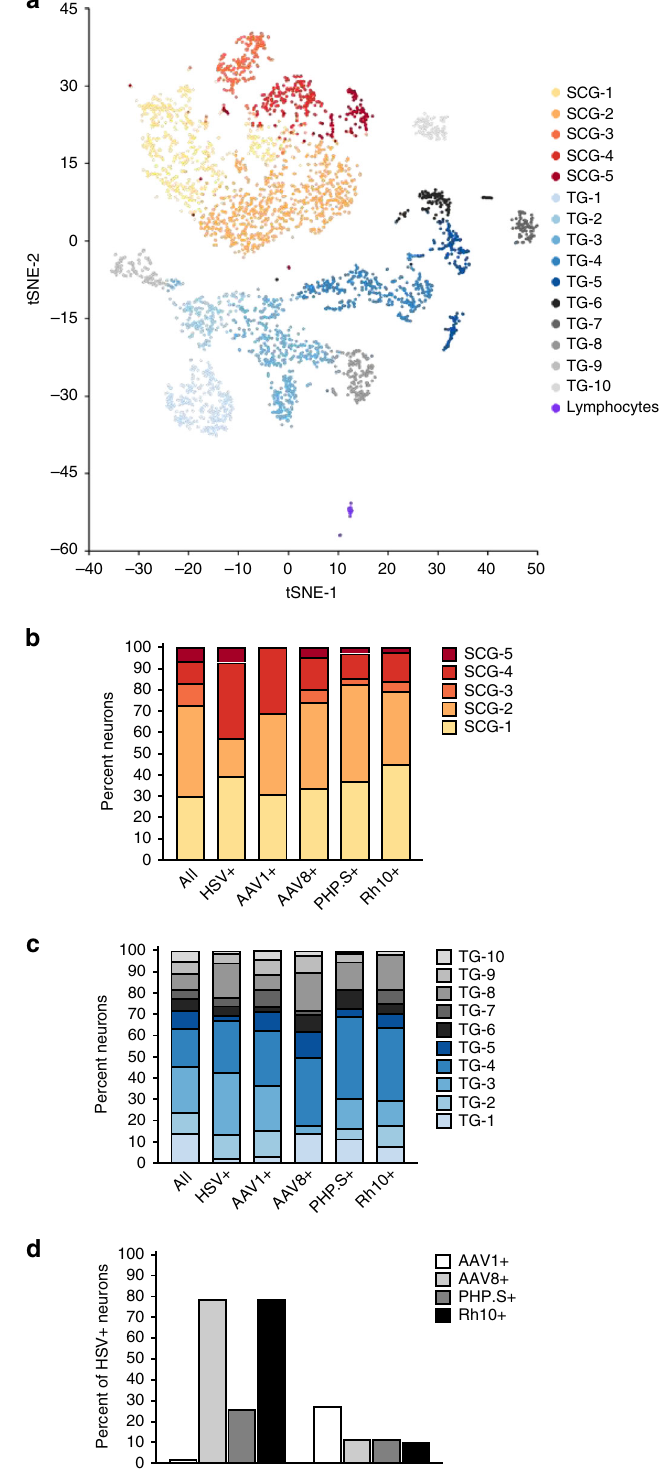
Fig. 7 Single-cell RNA-seq analysis of puri fi ed neurons. a tSNE plot of neurons dividing them into transcriptionally de fi ned clusters. Clusters of the neurons puri fi ed from the SCG ( n = 2041 with 94,797 mean reads and 5635 median genes per cell) colored with orange/red hues (SCG-1 – 5), and neurons puri fi ed from the TG ( n = 2319 with 99,817 mean reads and 5908 median genes per cell) are colored with blue/gray hues (TG-1 – 10). Lymphocytes are purple. b , c Fractional distribution of each neuronal cluster within all neurons, or neurons expressing HSV RNA or the transgenes carried by the indicated AAV serotype, across the SCG and TG. d Calculated percentage of HSV + cells in the SCG and TG that also express a given transgene mScarlet (AAV1 + ); mEGFP (AAV8 + ); DsRed.Express2 (PHP.S + ); TagBFP2 (Rh10 +